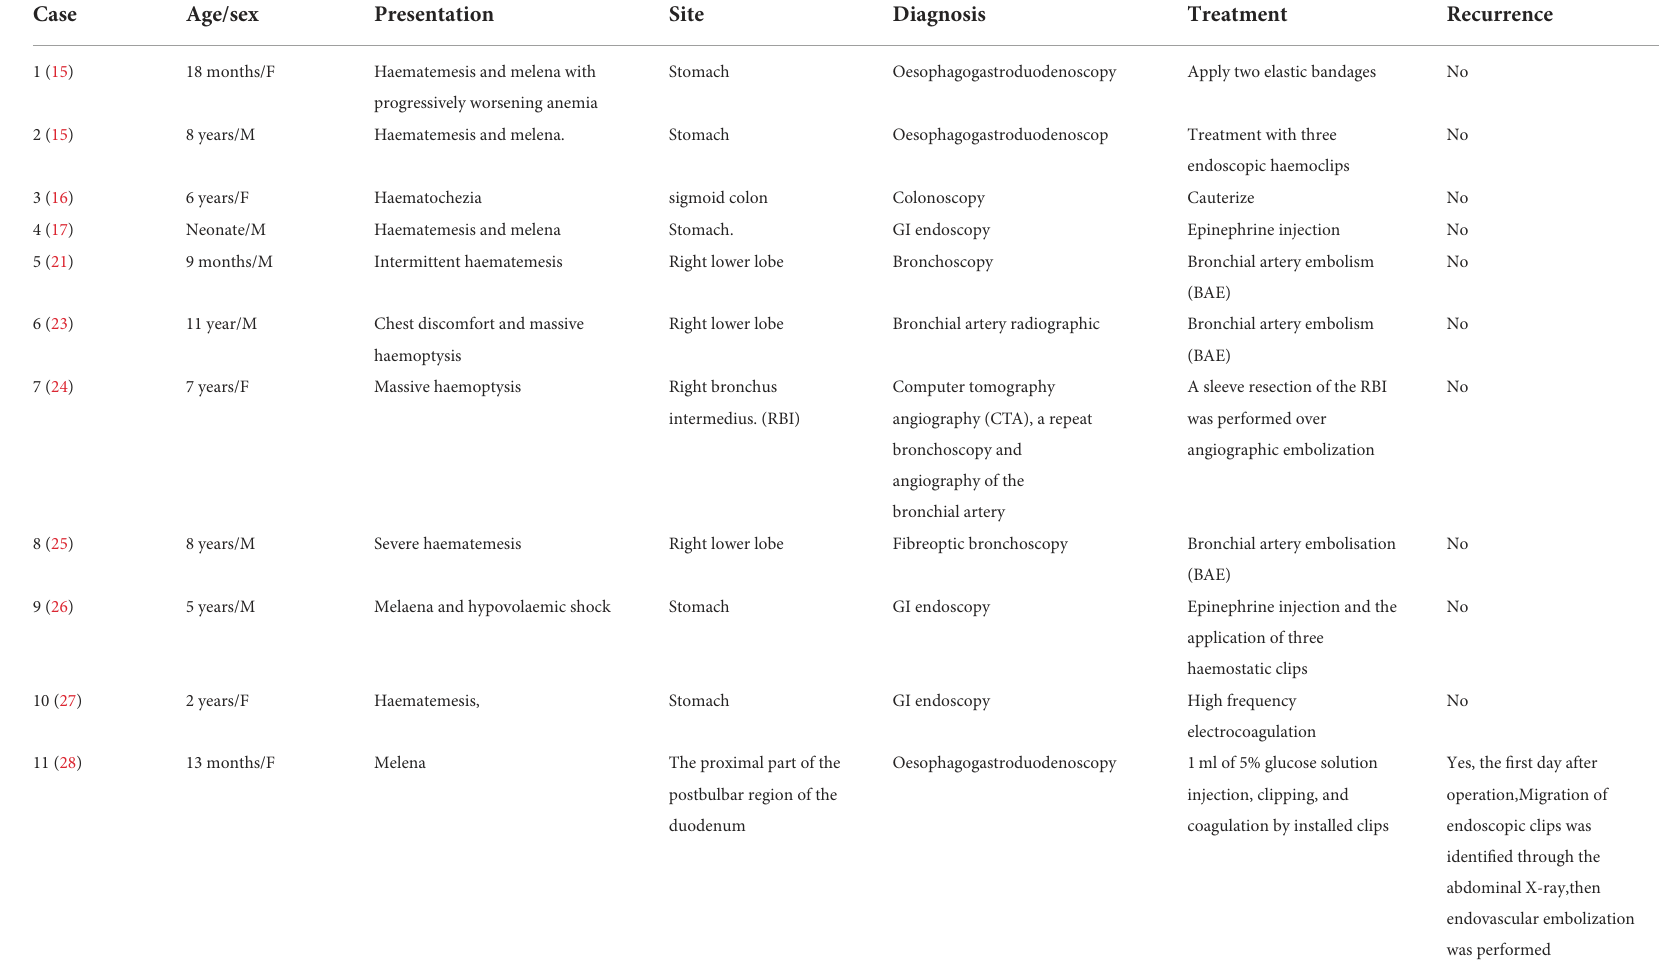
TABLE 1 Literature review on Dieulafoy’s disease in